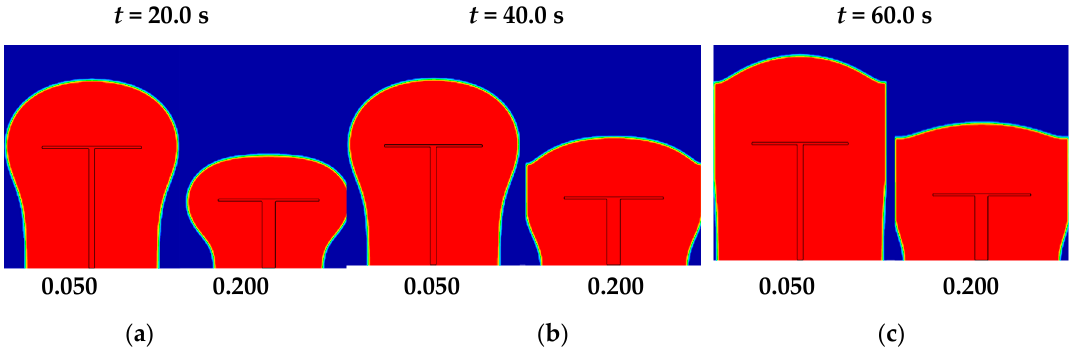
Figure 13. Resin volume fraction for φ = 0.05, H / L = 1.0, H 0 / H 1 = 10.0, for three di ff erent ratios of L 0 / H 0 = 0.075, ( L 0 / H 0 ) o = 0.100 and L 0 / H 0 = 0.300 as a function of time: ( a ) t = 20.0 s, ( b ) t = 40.0 s, ( c ) t = 60.0 s.